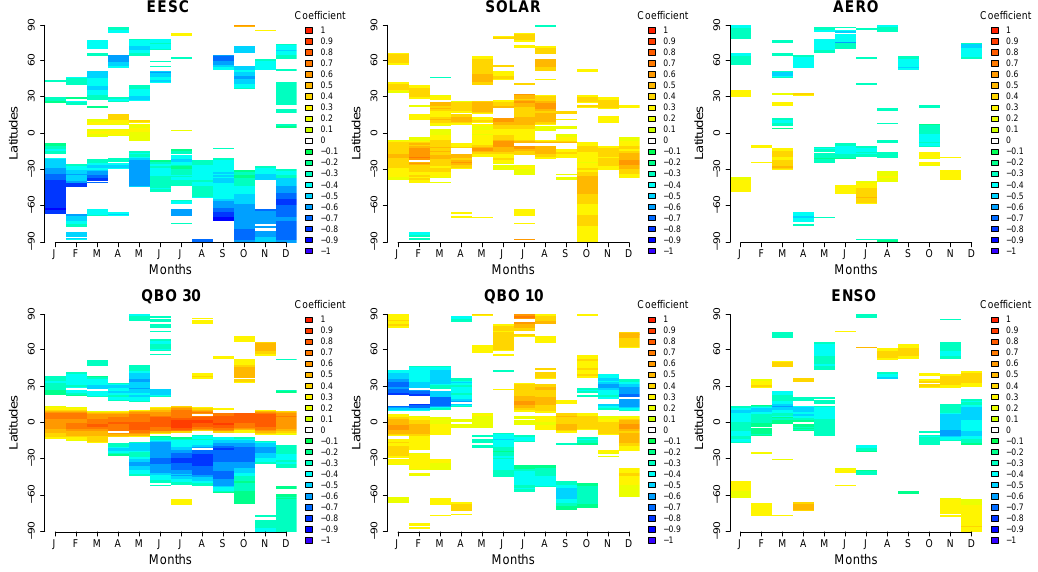
Figure 3. Monthly regression coefficient estimates for the nonseasonal explanatory variables. White regions indicate nonsignificant coeffi- cient estimates at the 90% confidence level. QBO10 and QBO30 represent the QBO index at 10 and at 30hPa,